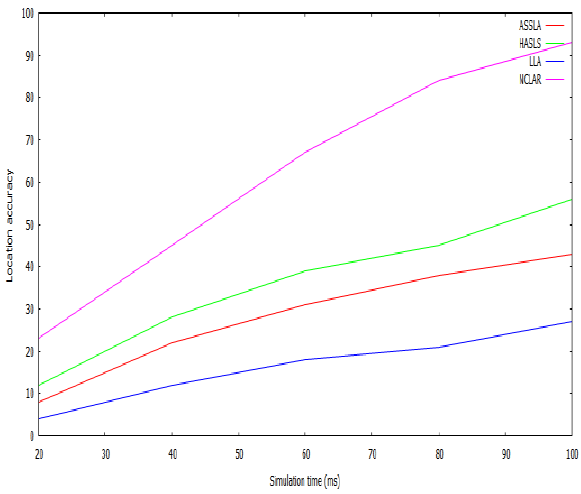
Figure 4. Packet Delivery Ratio Vs Number of Nodes